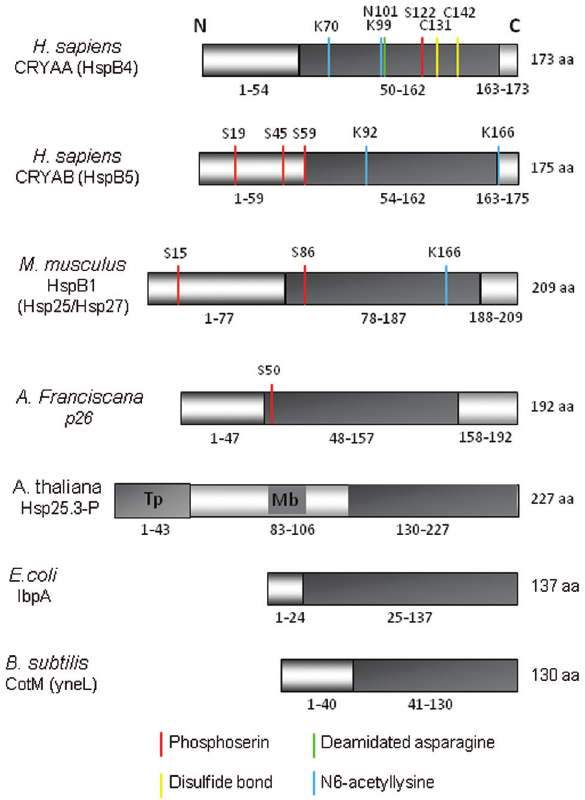
Figure 3 Comparative schematic composition of ACD-type sHSPs from different